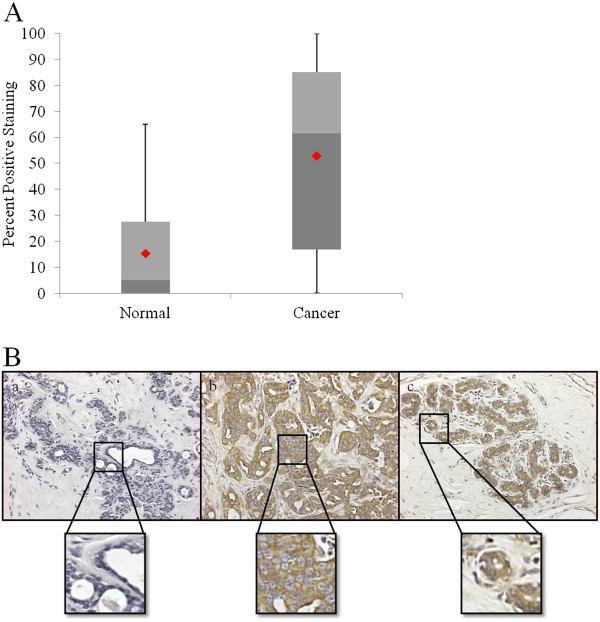
Gadd45a expression levels are elevated in human breast cancer samples compared to normal tissue. (A) Box and Whisker Plots, graphically depicting Gadd45a expression in human breast samples, demonstrate elevated levels of Gadd45a expression in carcinoma samples compared to normal tissue samples. Statistical significance was achieved between differences in mean percent staining between the two groups (P < 0.001, t-test). (B) Representative images from immunohistochemical analysis of Gadd45a on (a) normal breast tissue, (b) breast cancer tissue and (c) normal epithelial cells adjacent to cancer cells.